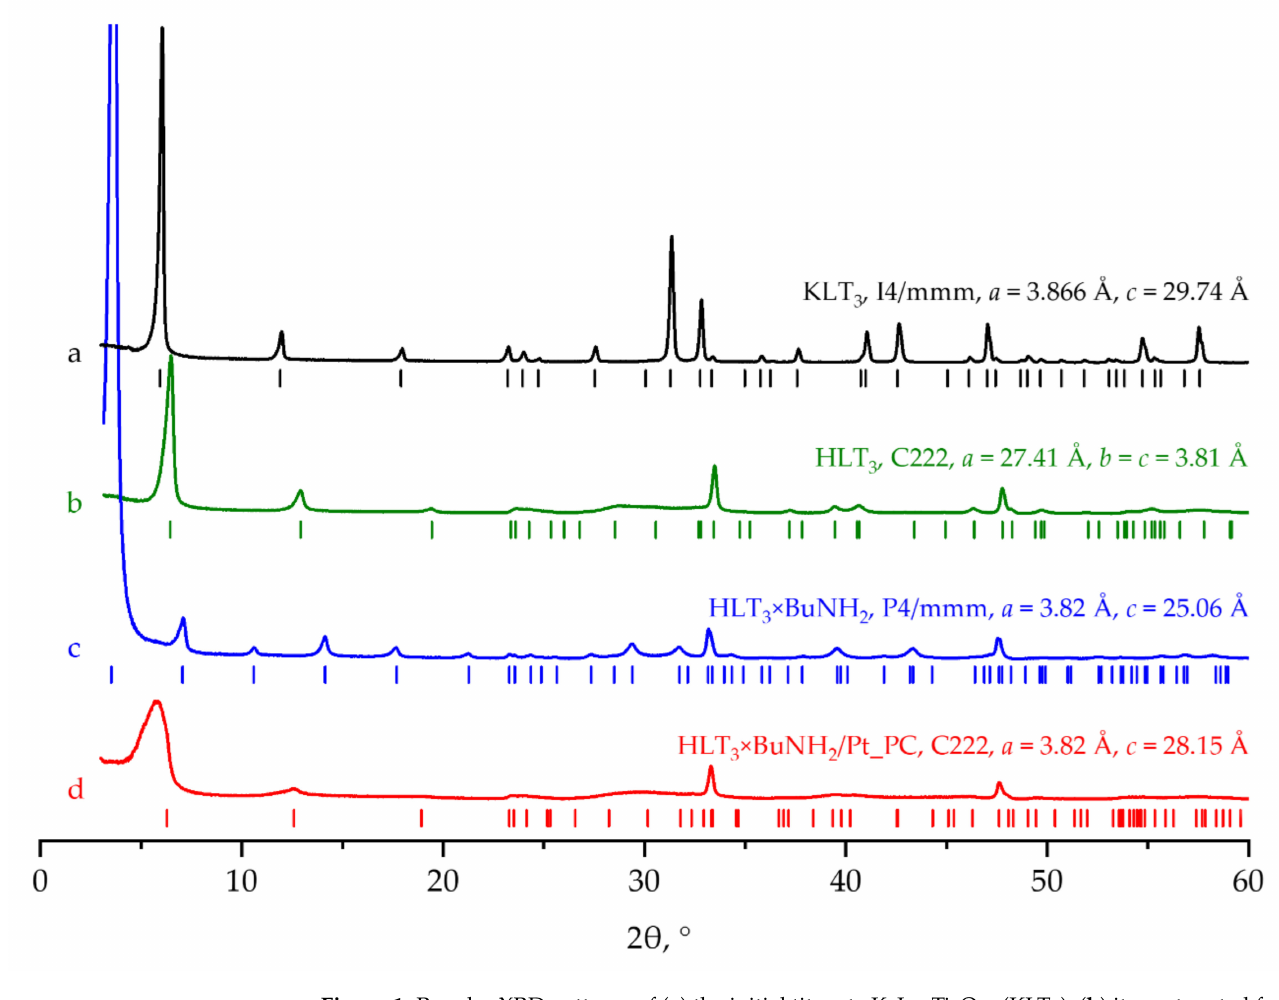
Figure 1. Powder XRD patterns of ( a ) the initial titanate K 2 La 2 Ti 3 O 10 (KLT 3 ), ( b ) its protonated form H 2 La 2 Ti 3 O 10 (HLT 3 ), ( c ) n -butylamine-intercalated form H 2 La 2 Ti 3 O 10 × BuNH 2 (HLT 3 × BuNH 2 ) and ( d ) platinized n -butylamine-intercalated form H 2 La 2 Ti 3 O 10 × BuNH 2 /Pt after 2.5 h of photocatalytic experiment (HLT 3 × BuNH 2